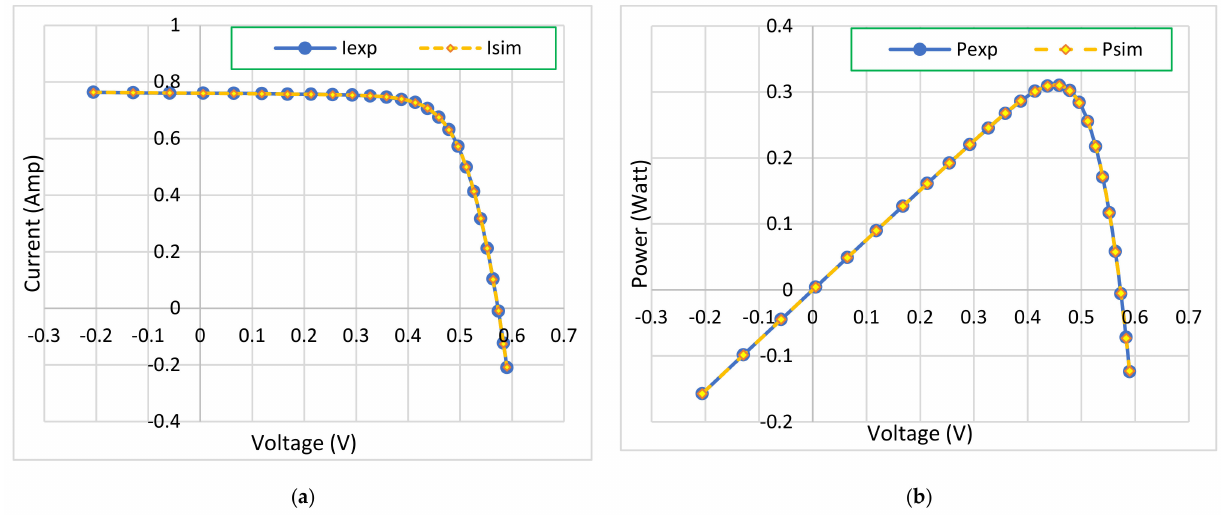
Figure 10. Characteristic curves for R.T.C. France DDM based on TFWO: ( a ) I–V ch/s and ( b ) P–V ch/s.